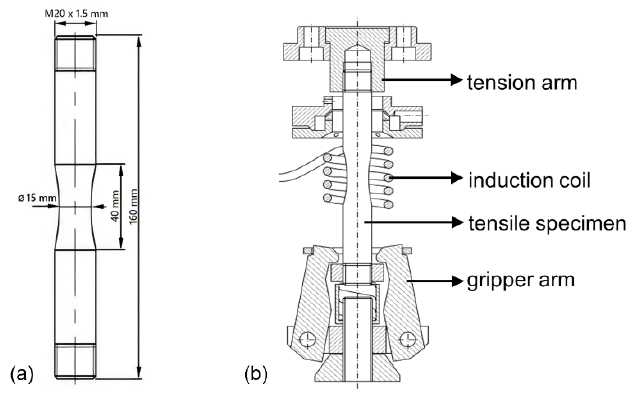
Figure 1. Sample geometry ( a ) and schematic assemble of the experiment ( b ) [30]. The samples are assembled in the machine in such a way that the lower part is fixed by a gripper arm, and the upper is attached to the tension arm. An induction coil heats the middle portion of the samples, and the temperature is measured by a Pt/Pt-Rh thermocouple spot welded in the